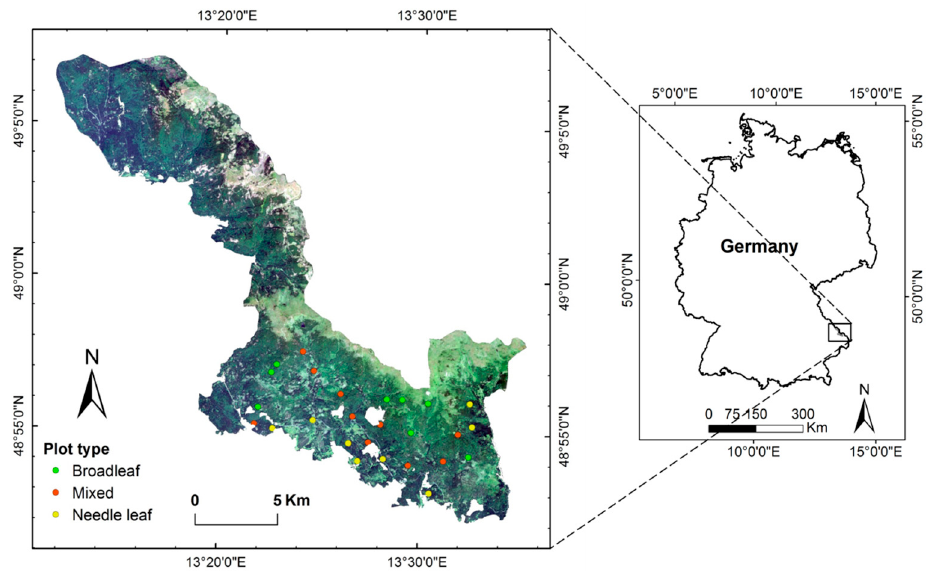
Figure 1. Location of the study area in Bavarian Forest National Park (BFNP), Germany and the sampling plots.